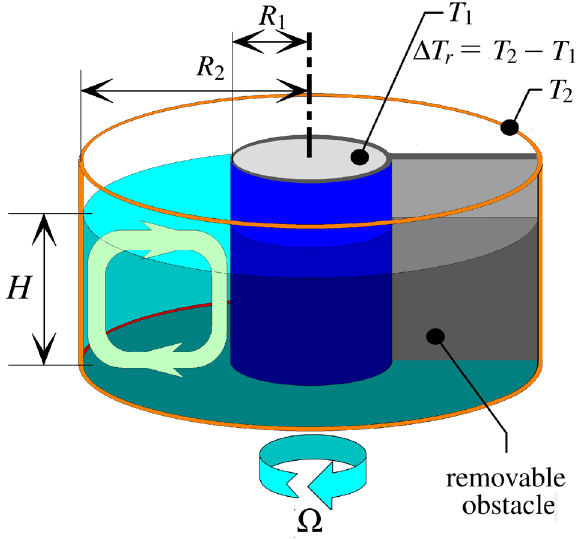
Figure 1. The sketch of the experimental setup. The water body is located in the annular domain between the two coaxial cylinders. The entire tank is rotating around its axis in the clockwise direction at rotation rate (cid:31) —as indicated by the arrow at the bottom—to imitate the Southern Hemisphere configuration. The inner and outer sidewalls are kept at constant cold ( T 1 ) and warm ( T 2 ) temperature, respectively, maintaining a radial (“meridional”) temperature difference forcing, (cid:31) T r = T 2 − T 1 . The removable vertical obstacle is sketched with gray. The infrared sensor was mounted above the annular gap (not co-rotating), and thus scanned the surface temperature field of the water as it moved underneath. The light green loop (left) depicts the direction of the basic overturning flow in the tank. The figure was created using KolourPaint for Ubuntu linux, Release 20.12.3 (freely available and downloadable at https:// apps. kde. org/ kolou rpaint/).